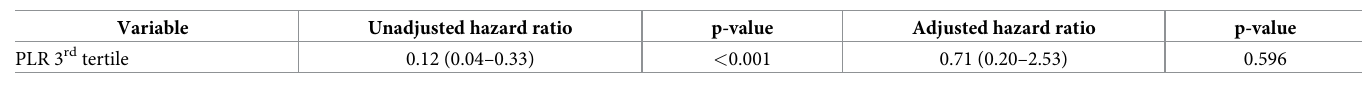
rates was predominant in the early phase (in 10 days). Furthermore, PLR was significantly associated with in-hospital mortality after adjusting for the baseline characteristics,